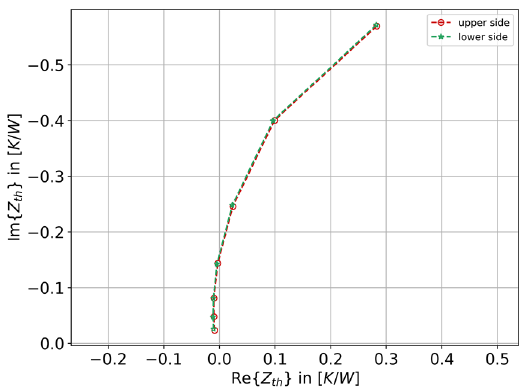
Figure 7. Symmetry of the test setup on the top and bottom types at the same conditions ( T amb = 25 °C, SOC = 50% and I ≙ 2C).